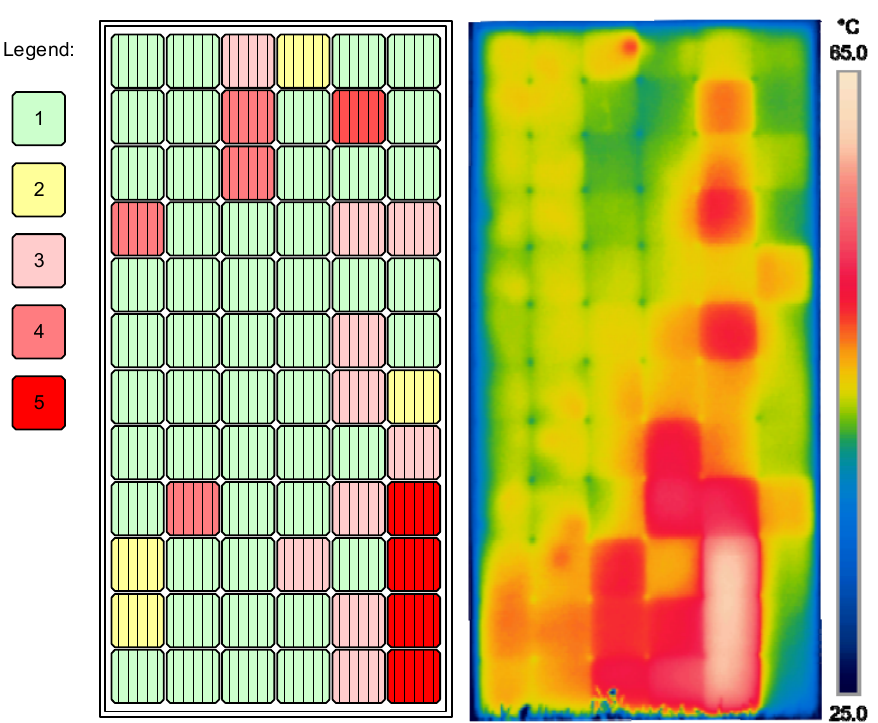
Figure 29. Damage classification by visual inspection ( left ) and thermogram ( right ) of module number 3.